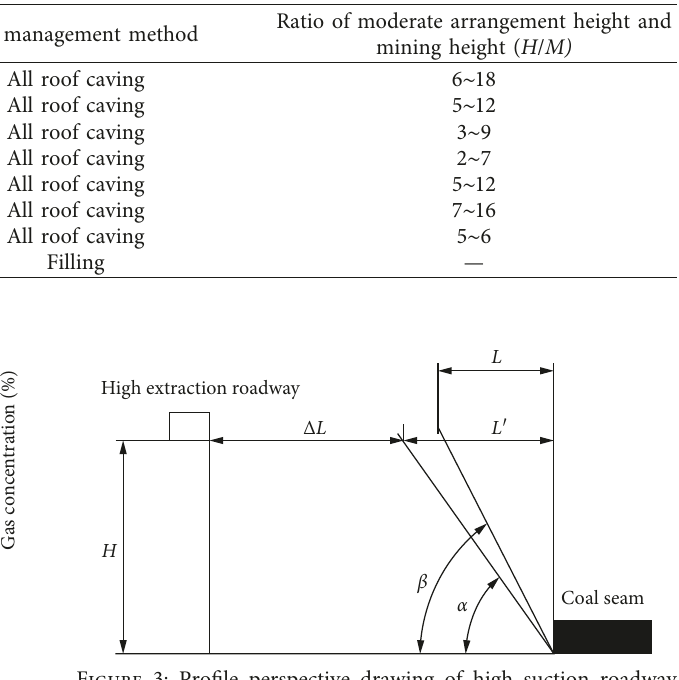
Figure 3: Profile perspective drawing of high suction roadway arrangement.